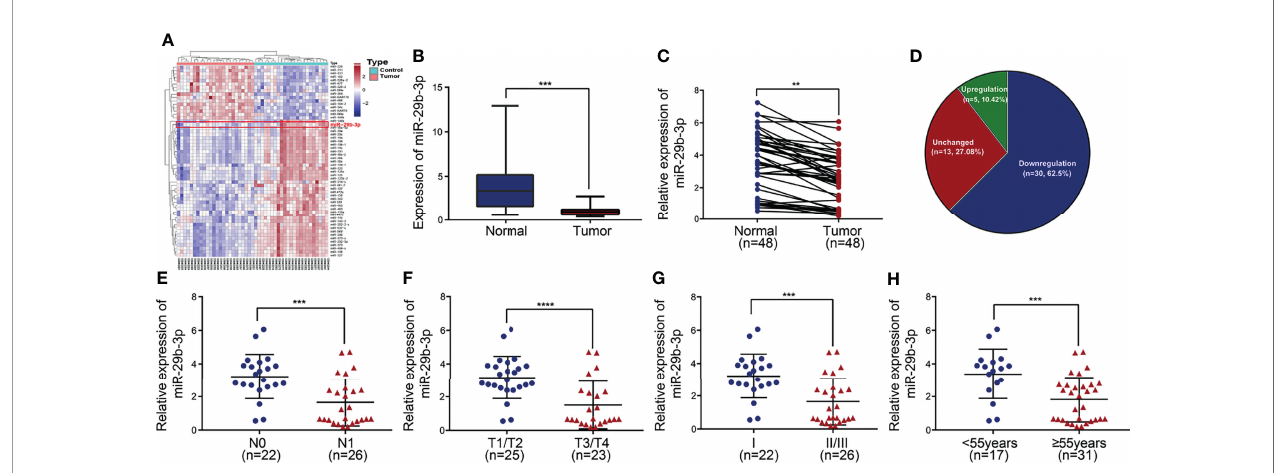
FIGURE 1 | Downregulation of miR-29b-3p is associated with disease progression in PTC. (A) Heatmap of differentially expressed genes in GEO dataset coloring the samples groups. (B) Expression level of miR-29b-3p in PTC based on data retrieved from the GEO database and the ArrayExpress database. (C, D) Theexpression of miR-29b-3p was evaluated by qRT-PCR in 48 paired human PTC tissues and their matched adjacent non-tumor thyroid tissues. MiR-29b-3p expression was signi fi cantly downregulated in PTC tumor tissues compared with the corresponding non-tumor thyroid tissues (U6 was used as an internal control). (E – H) Relationships between miR-29b-3p expression and TMN stage of PTC. In the fi gure, **p < 0.01, ***p < 0.001, ****p <